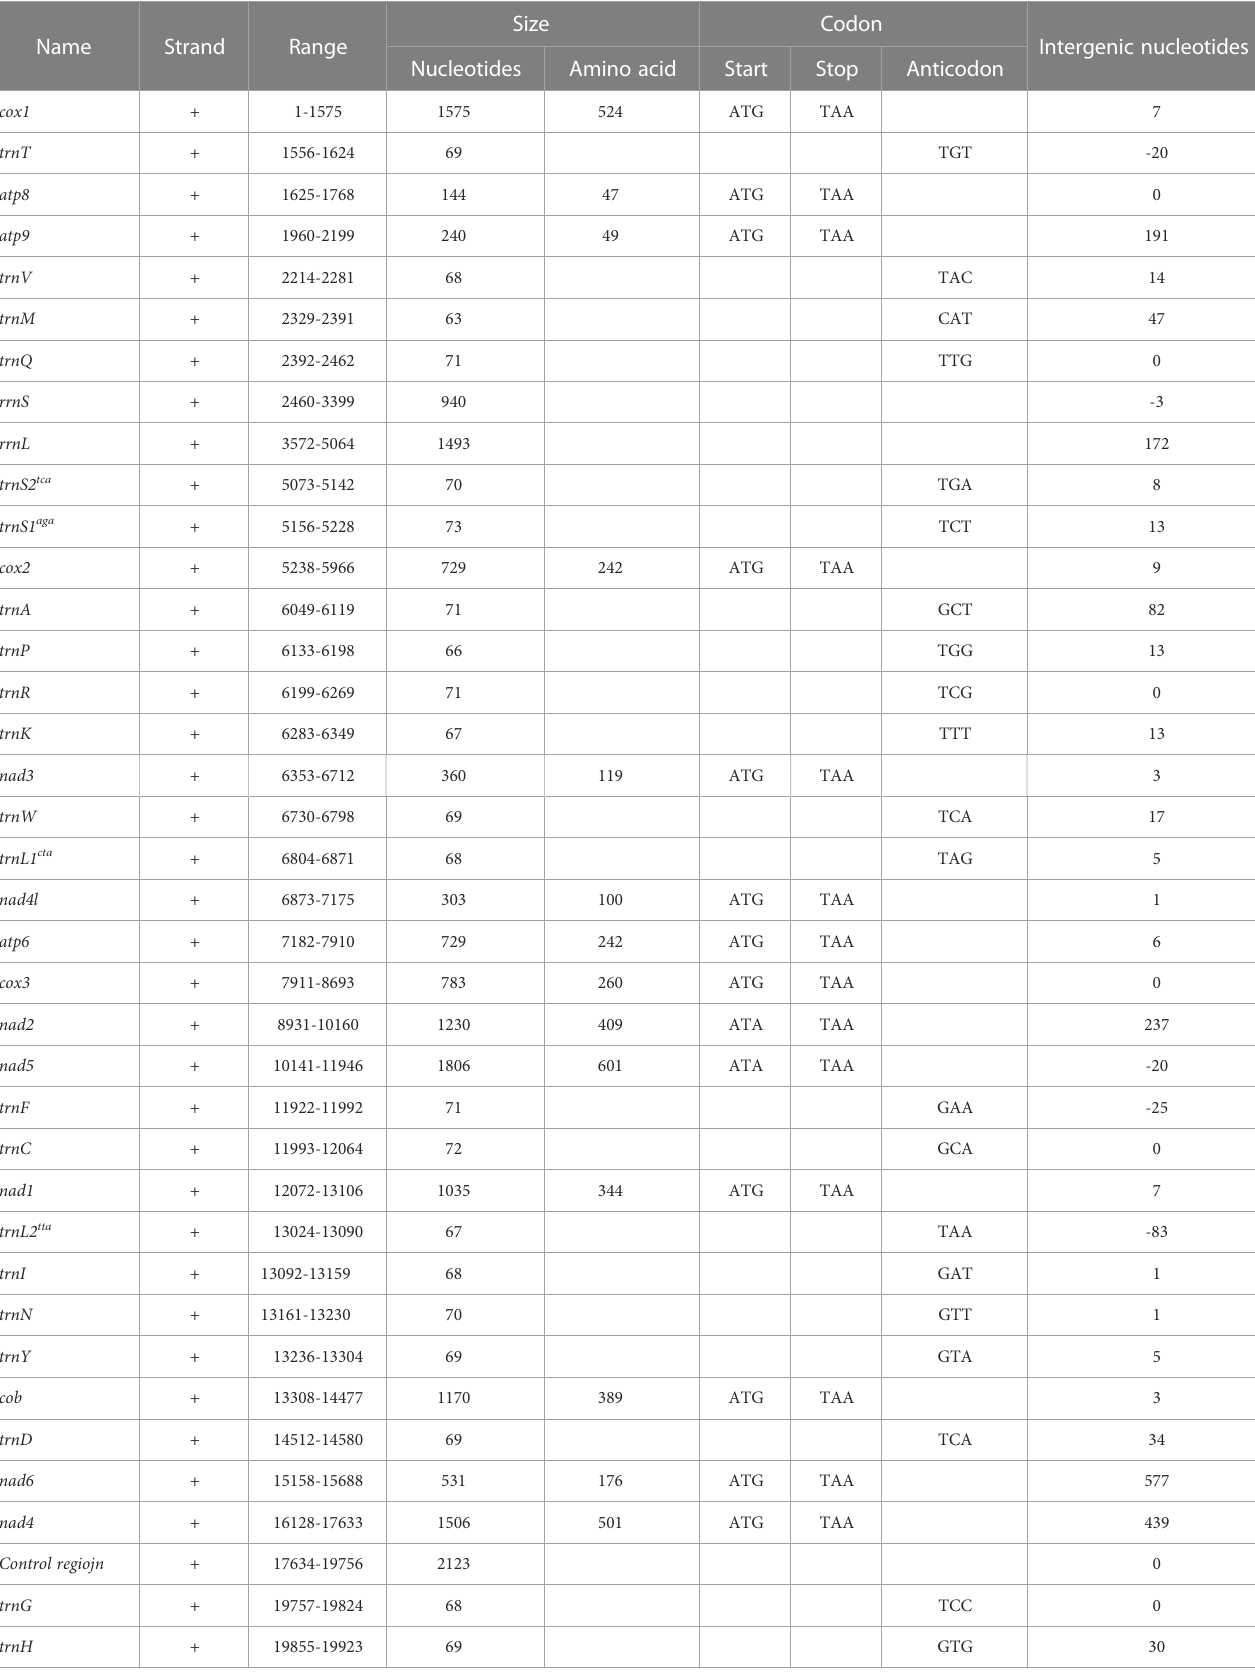
TABLE 3 Mitogenome organization of Caulophacus ( Caulodiscus ) iocasicus sp.